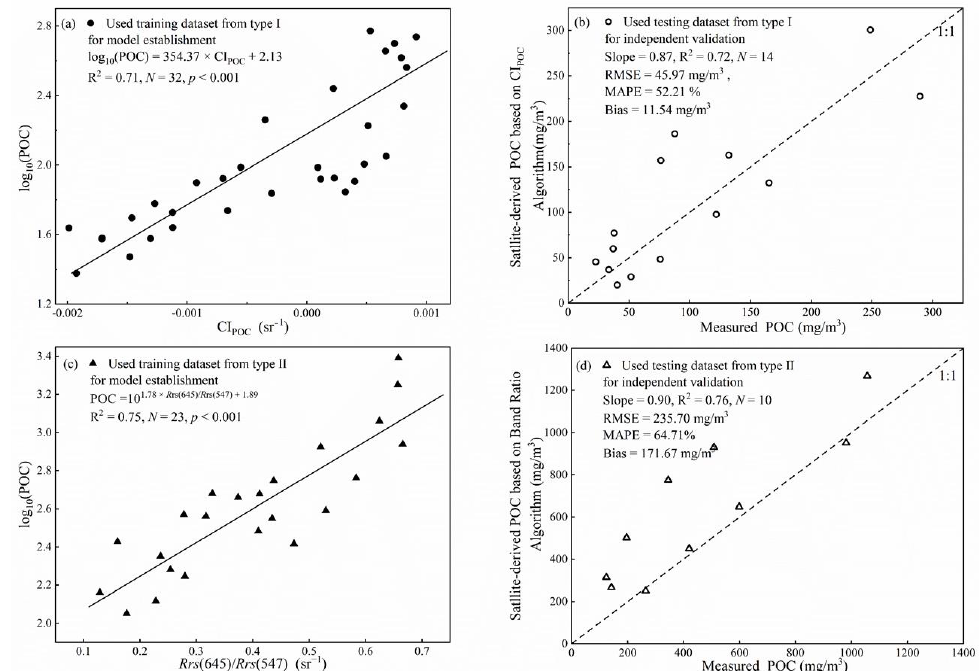
Figure 3. ( a ) Relationships between in-situ log 10 (POC) and satellite-derived CI POC , and ( c ) in-situ log 10 (POC) and satellite-derived Rrs(645)/Rrs(547); comparison between measured POC and satellite-derived POC determined from the CI POC ( b ) and band-ratio ( d ) algorithms.